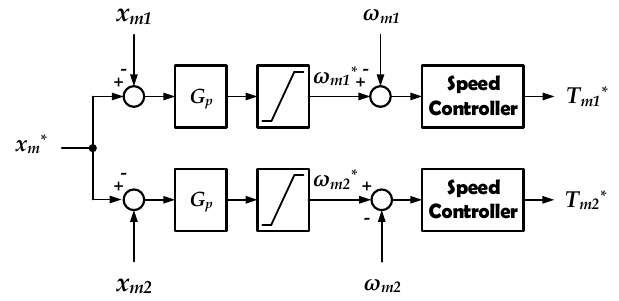
Figure 7. Moving length control scheme of dual motor drives.